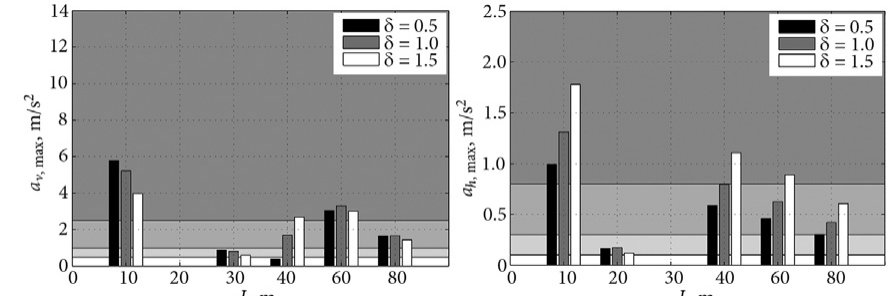
Fig. 9. Vertical and lateral accelerations induced by a flow of walkers: variable density